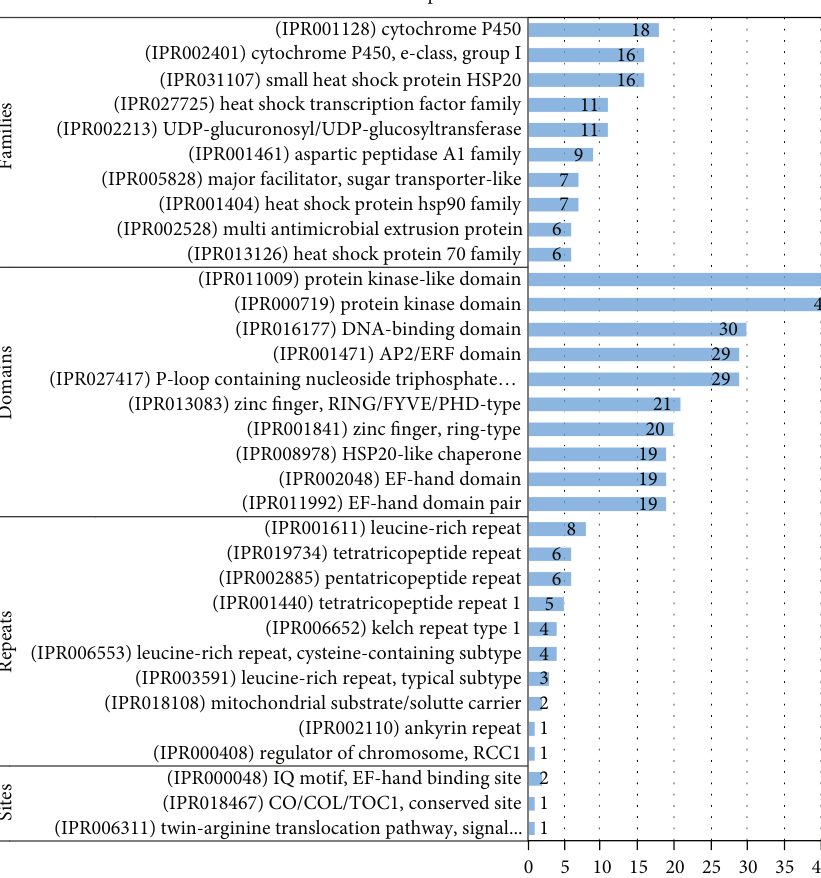
Figure 1: Top 10 IPS families, domains, repeats, and sites for upregulated DEGs responsive for heat